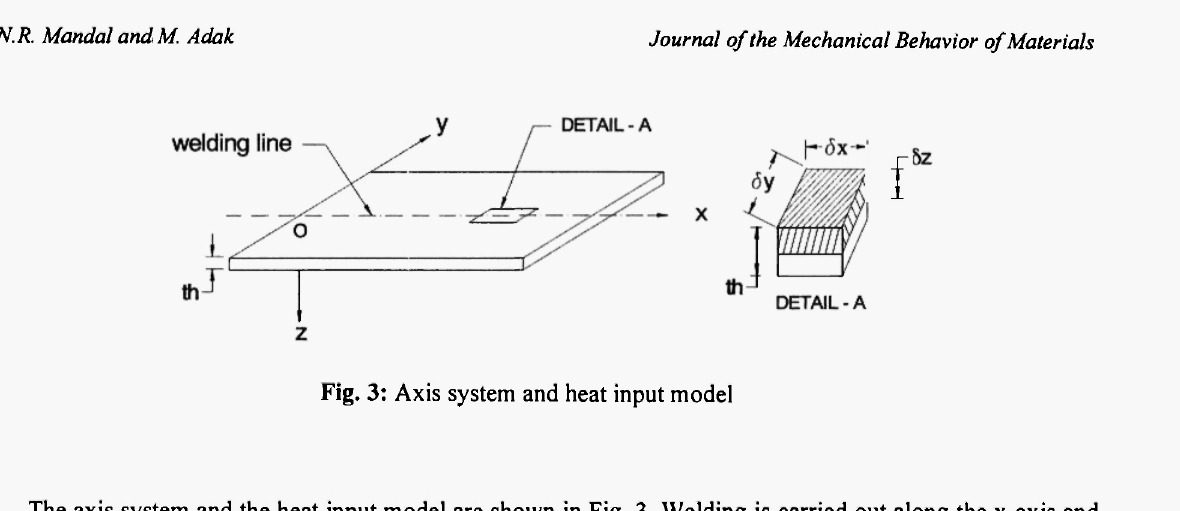
Fig. 3: Axis system and heat input model